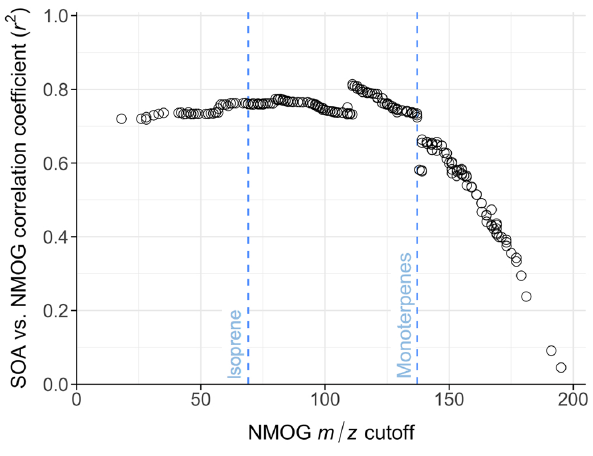
Figure 4. Correlation coefficients ( r 2 ) between OA carbon mass added and the summed NMOG carbon mass above some ion mass ( m/z ) cutoff. For example, the point labeled “isoprene” shows the correlation between SOA carbon mass and initial NMOG carbon mass for all measured ions with mass-to-charge ratio equal to or greater than that of isoprene (i.e., species of molecular weight 68gmol − 1 or higher). Initial NMOG carbon mass is calculated prior to oxidation and data points all correspond to r 2 values at 1d of atmospheric aging time. Correlation coefficients are high for all cutoff points below monoterpenes, then drop off due to loss of signal and the importance of smaller compounds to SOA